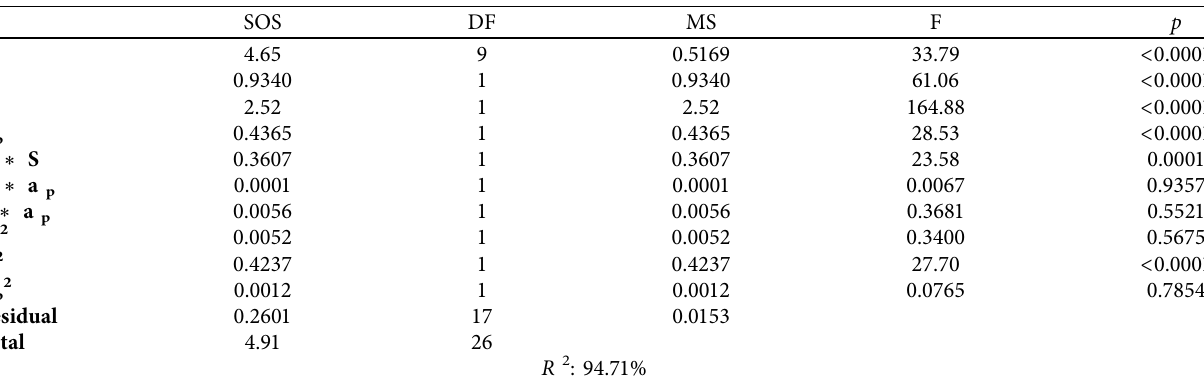
Figure 6: Plots of trained network with respect to target for (a) train, (b) validate, (c) test, and (d) all. Table 7: